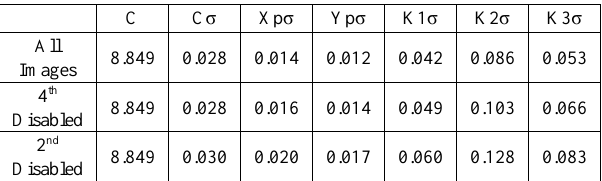
Table 8. Sigma statistics for proposed aerial mission A (M3) comparing the removal of every 2 nd and 4 th image with oblique imagery at 75ft.